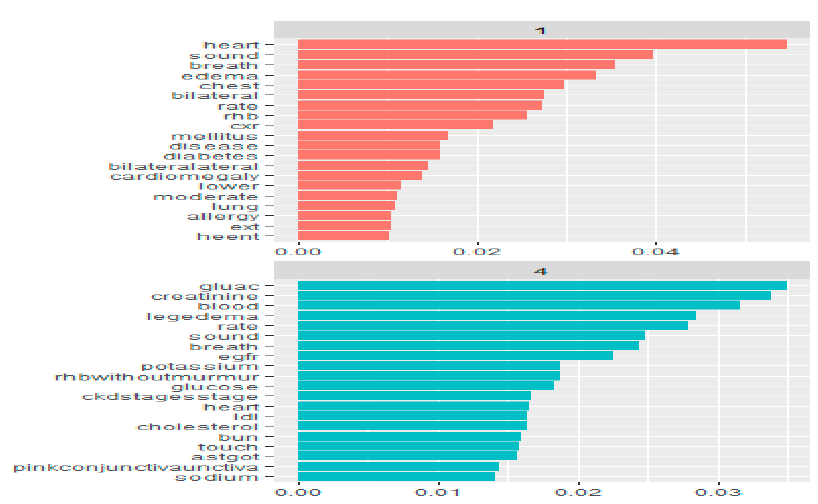
Figure 6. Word frequency distribution of 20 words in six topics (E11 Topics 1 and 4).